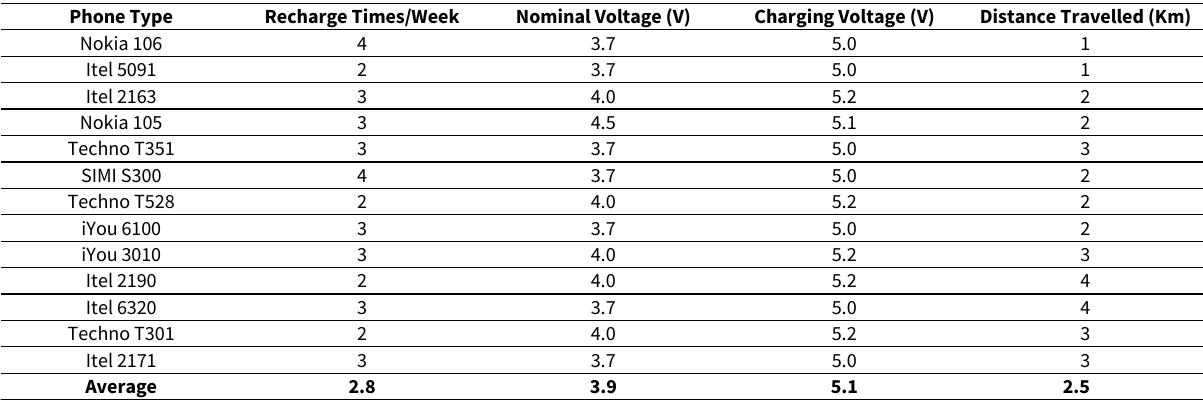
Table 1. Response from Mobile